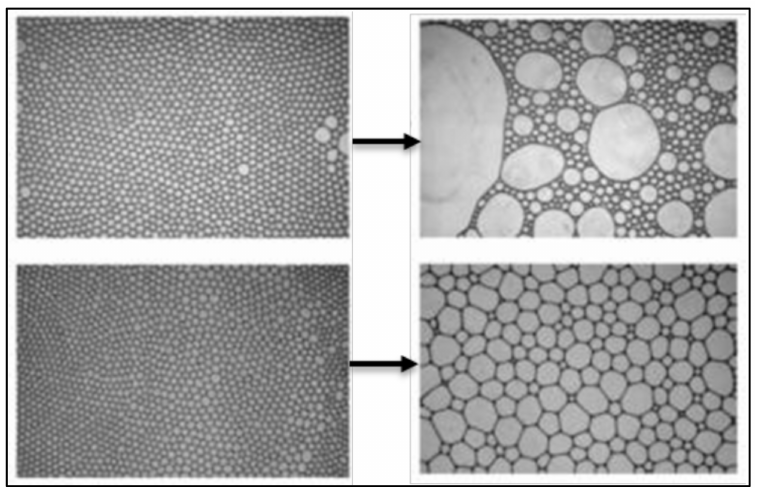
Figure 15. The difference between coalescence ( top ) and coarsening ( bottom ) (Reprinted with the permission from Govindu et al. [59]). Copyright 2020, Society of Petroleum